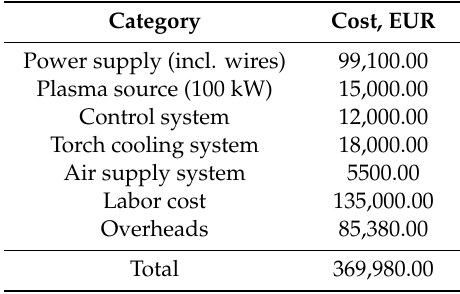
Table 1. Breakdown of the investment cost of the plasma installation for assisted combustion in a boiler, working with a 200 MW el power unit.